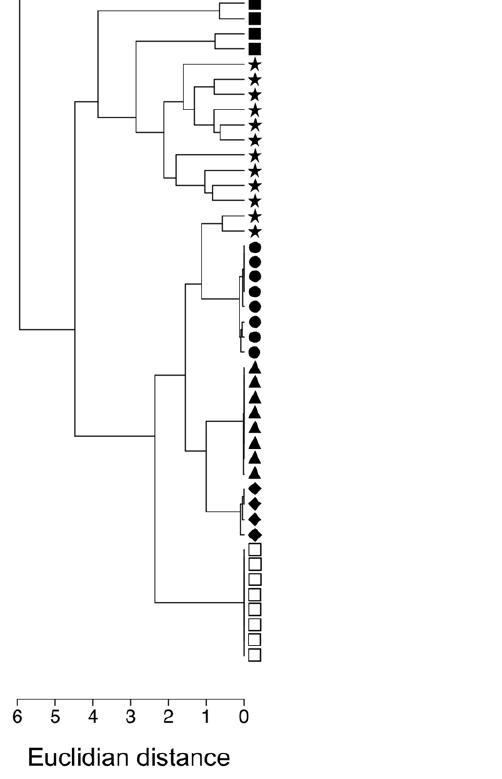
Figure 2. Hierarchical clustering (UPGMA) of the volatile blends emitted from differentially treated plants. Each tip corresponds to one replicate. Plant treatments were: untreated control ( % ); LCA herbivory ( X ); scissor damage ( m ); pincushion damage ( JA-treatment ( w ); LCA-herbivory with subsequent JA-treatment ( & ).